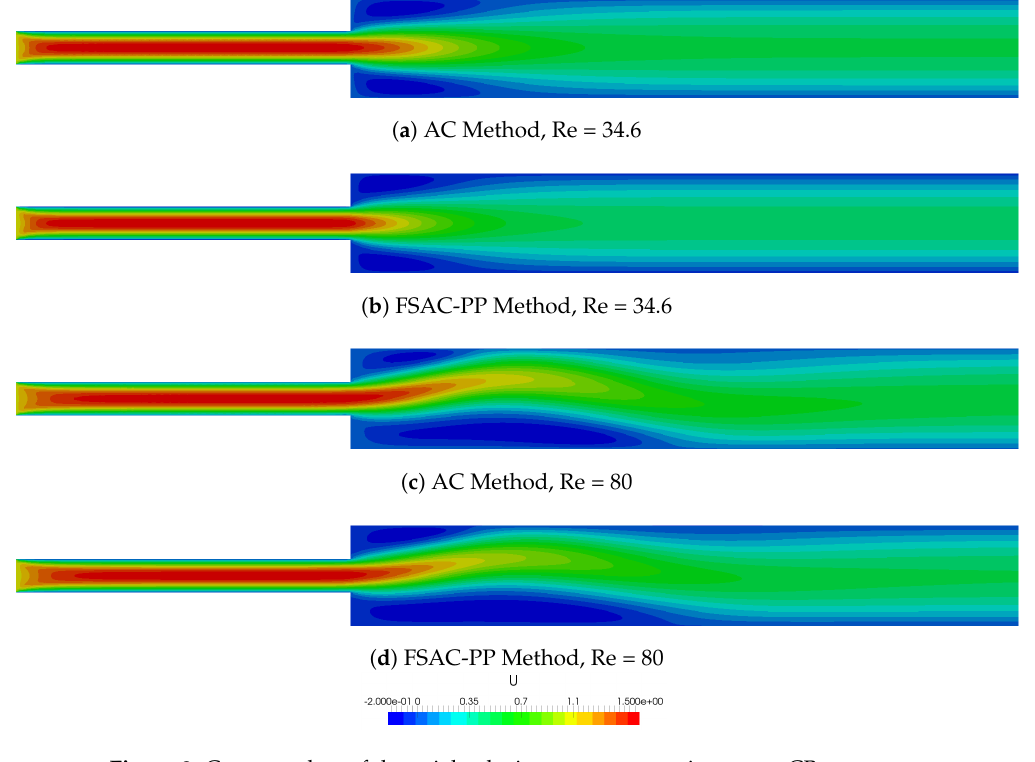
Figure 3. Contour plots of the axial velocity component using a non-CB treatment.